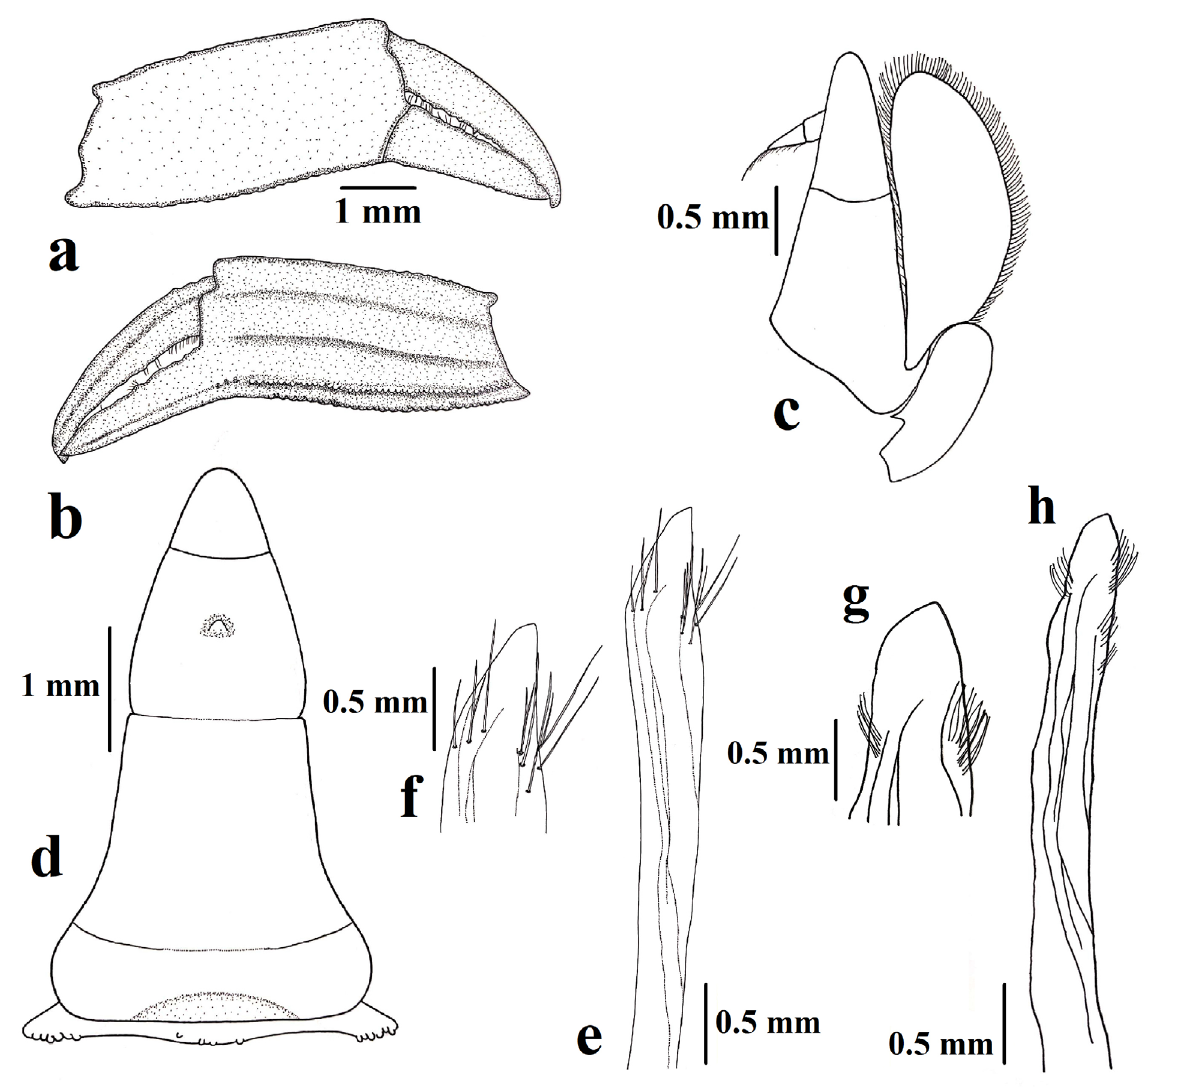
Figure 3. Bellayra sexangula gen. nov., comb. nov., lectotype, male (CL 7.24 mm, CB 7.85 mm) (ZSI-893/10). a , Right chela, outer view; b , right chela, inner view; c , left third maxilliped, outer view; d , abdomen; e , G1 abdominal view; f , G1 apical lobe; g , G1 apical lobe, male (CL 7.3 mm, CB 8.15 mm) (LFSc. ZRC-149); h , G1 abdominal